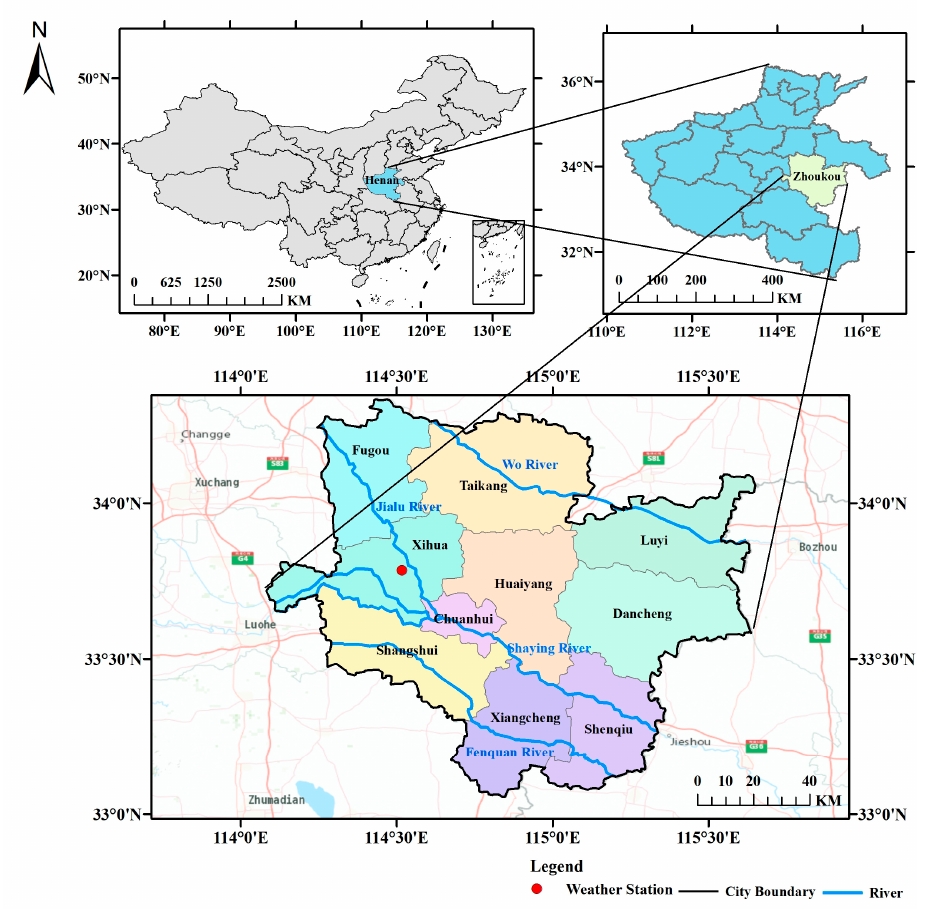
Figure 2. Location of Zhoukou City.